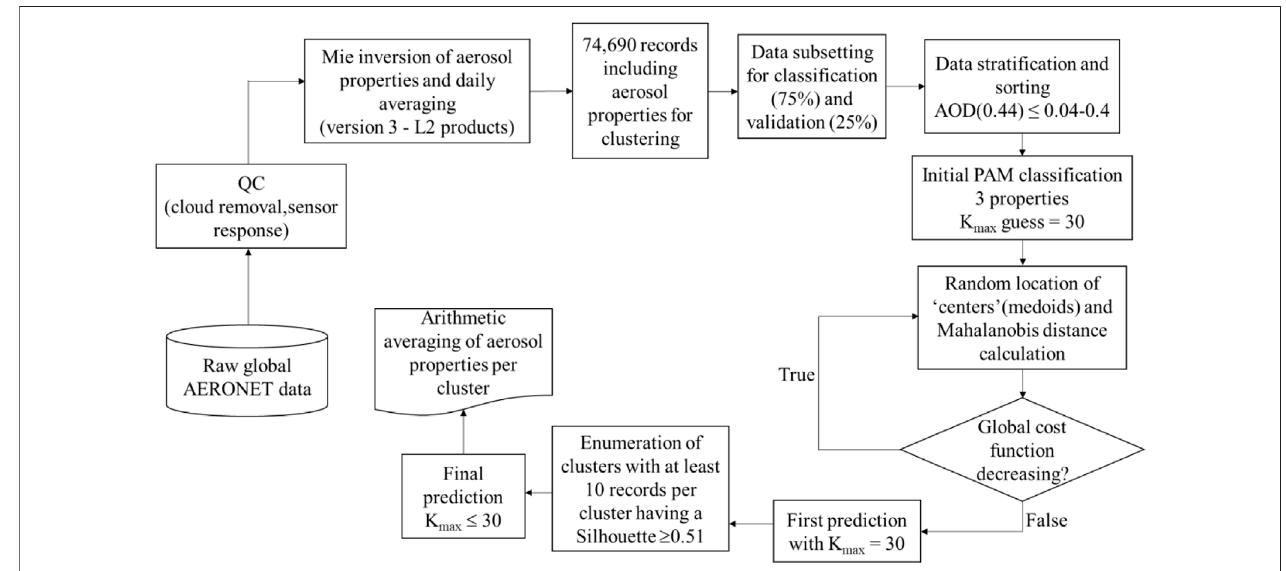
FIGURE 3 | PAM classi fi cation of